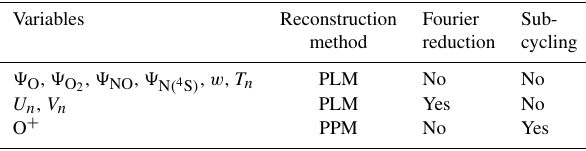
Table 1. The basic ring average settings of variables (column 1) and the corresponding reconstruction method (column 2), Fourier reduction (column 3), and sub-cycling (column 4) in the TIEGCM. Variables Reconstruction Fourier